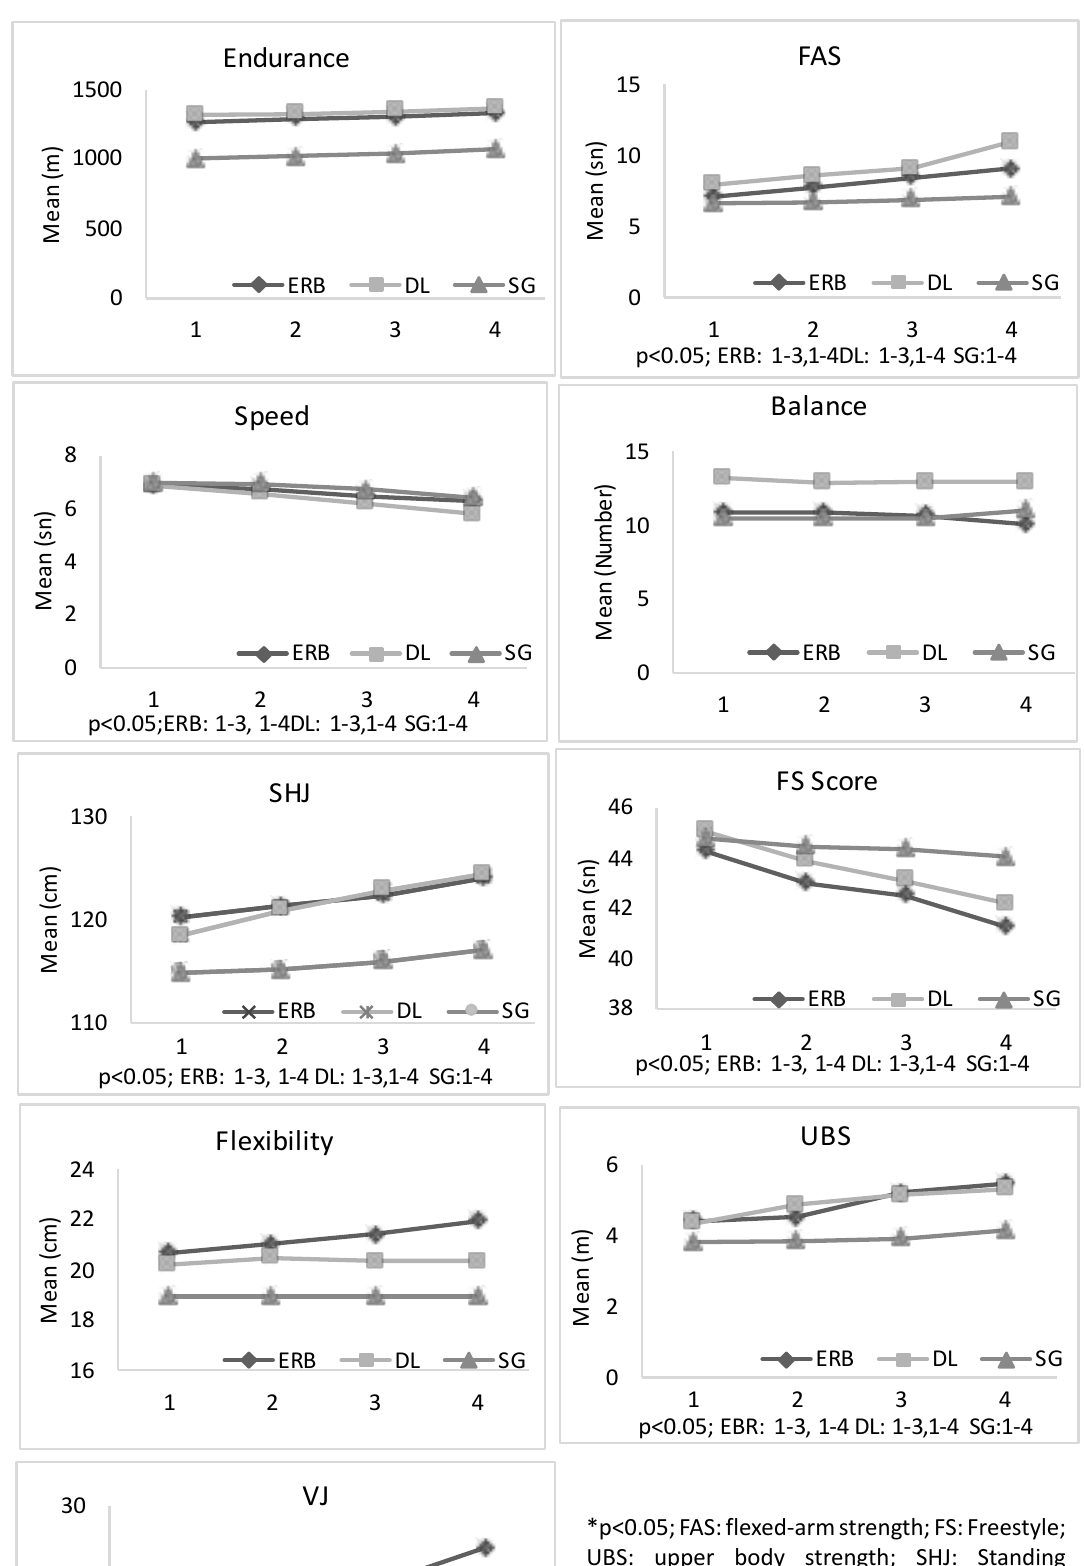
Figure 2. The motoric and freestyle score variables according to the